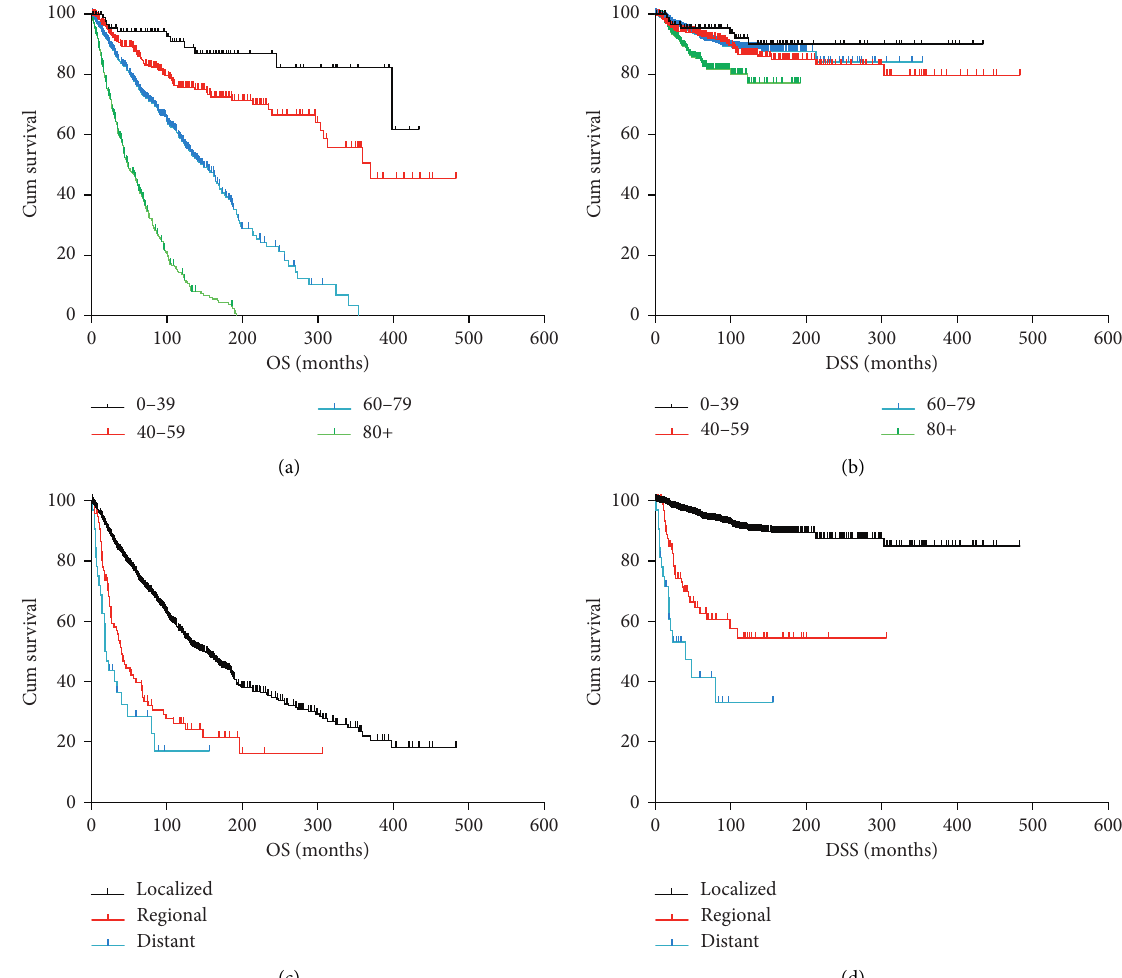
Figure 2: Kaplan-Meier survival analysis for each group: (a) OS for patients with eyelid PMM by age range; (b) DSS for patients with eyelid PMM by age range; (c) OS for patients with eyelid PMM by stage at diagnosis; (d) DSS for patients with eyelid PMM by stage at diagnosis. PMM, primary malignant melanoma; OS, overall survival; DSS, disease-specific